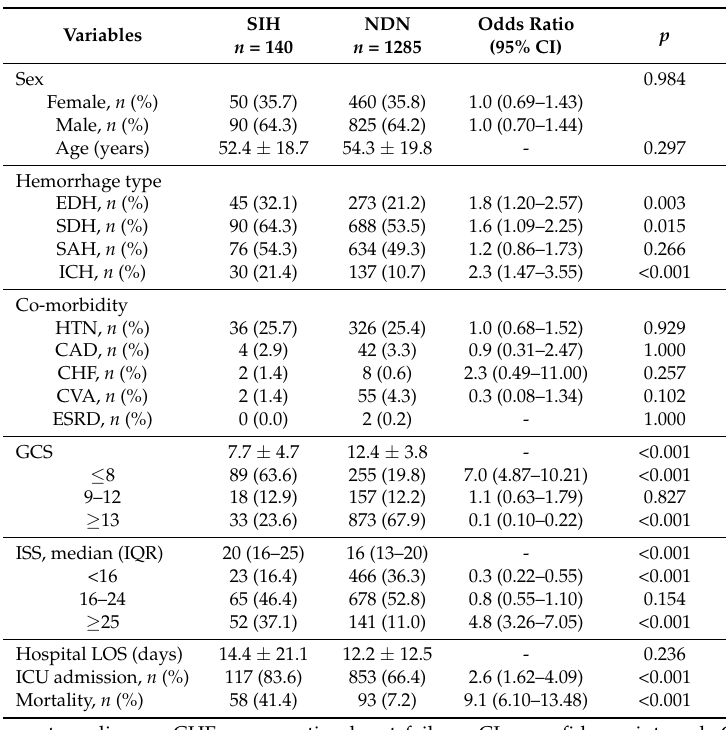
Table 1. Comparison of the characteristics and outcomes of the SIH and NDN groups of